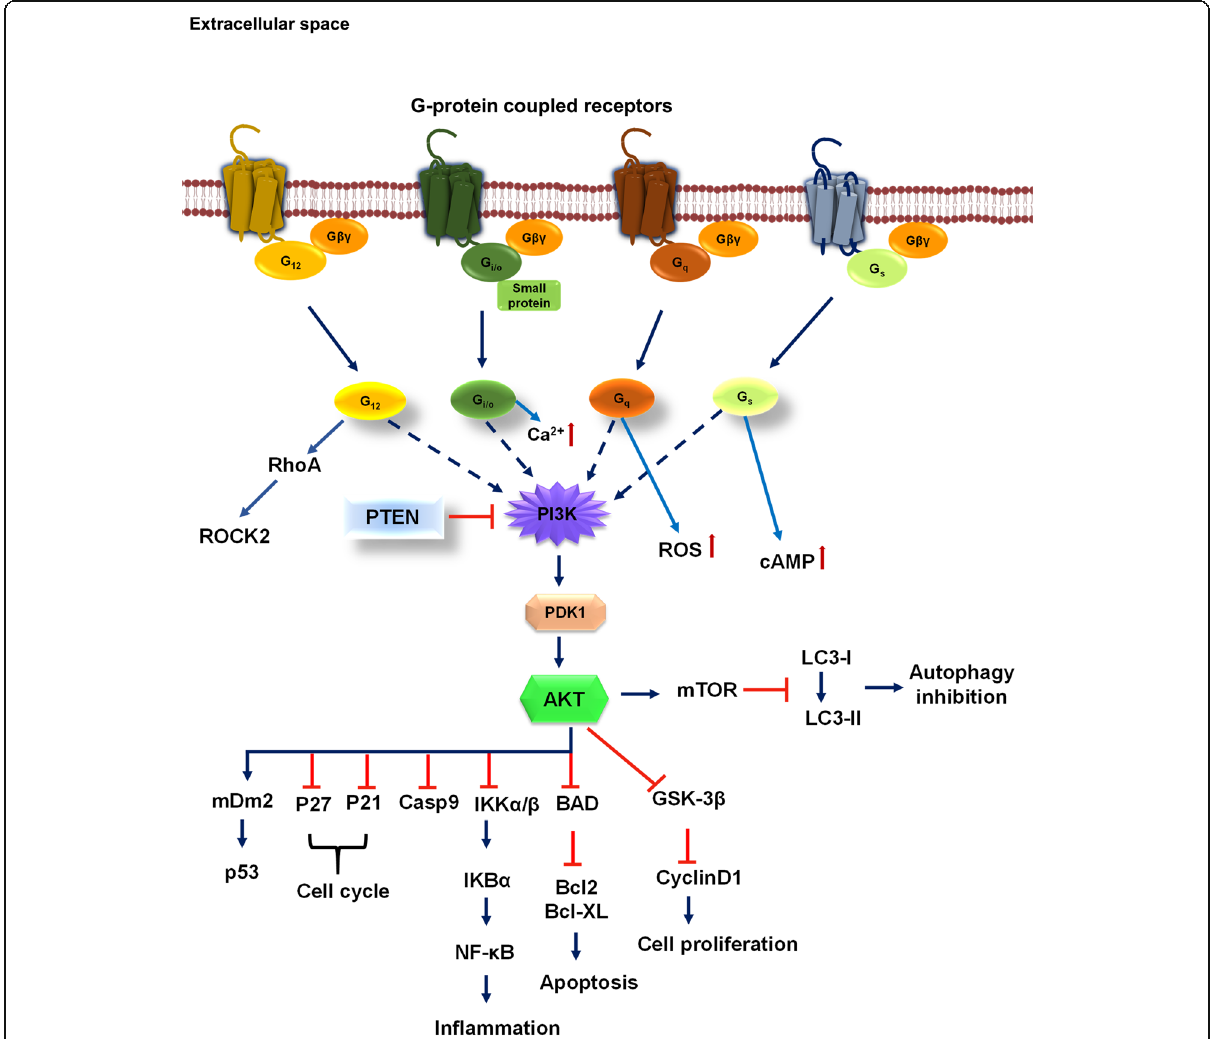
Fig. 1 GPCR influence PI3K/Akt signaling. Among various GPCR G 12/13 , G i/o , G q , G s are known to activate PI3K/Akt cell survival pathway via its G α or G βγ subunit. Along with PI3K/Akt signaling G 12/13 activate RhoA/ROCK pathway, Gi/o involves in maintaining intracellular levels of Ca 2+, G q with the ROS production, and Gas with secondary messenger cAMP. The regulation of PI3K is carried out by PTEN, a phosphatase of PI 3, 4, 5-P3, which inhibits PI3K directly. Upon activation of PI3K, Akt phosphorylation occurs via PDK1 kinase, followed by mTOR pathway activation, which inhibits autophagy response by inhibiting the conversion of LC3-l to LC3-ll. Akt specifically affects various downstream signaling pathway such as inhibition of GSK-3 β , BAD, IKK, Casp9, P27, P21, and activates mDm2, which is involved in the p53-mediated response. This indicates a